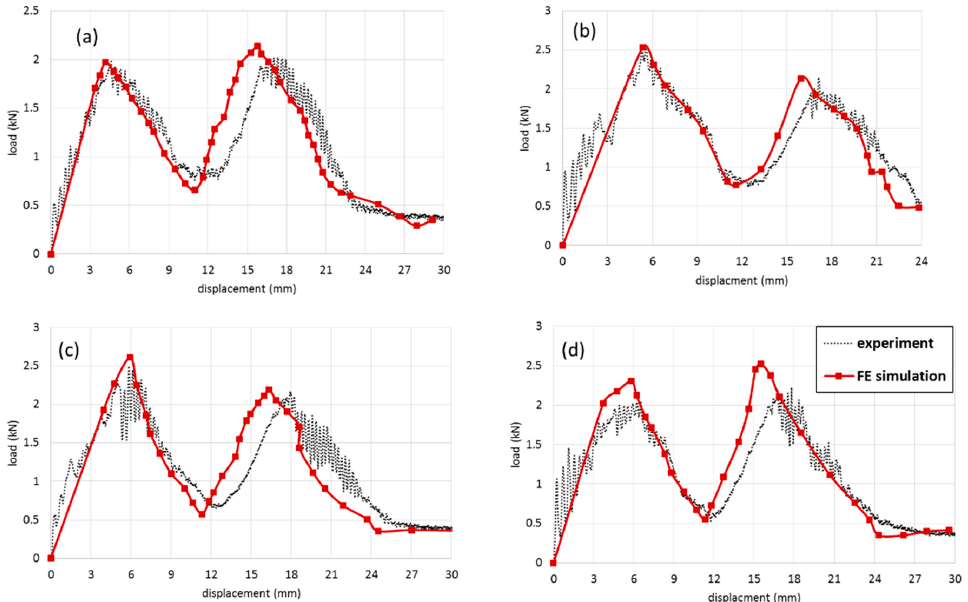
Figure 10. Comparison between experimental results and FE simulation for ( a ) FCS, ( b ) 1 mm PFCS, ( c ) 2 mm PFCS, ( d ) 3 mm PFCS panels subjected to 500 mm/min. Figure 10b–d represent the load-displacement curves for PFCS 1, 2, and 3 mm panels, respectively. Comparison between the results of the FCS panel and PFCS show that using pin reinforced in the sandwich panel can increase the peak load and energy absorption of a panel up to 20%.